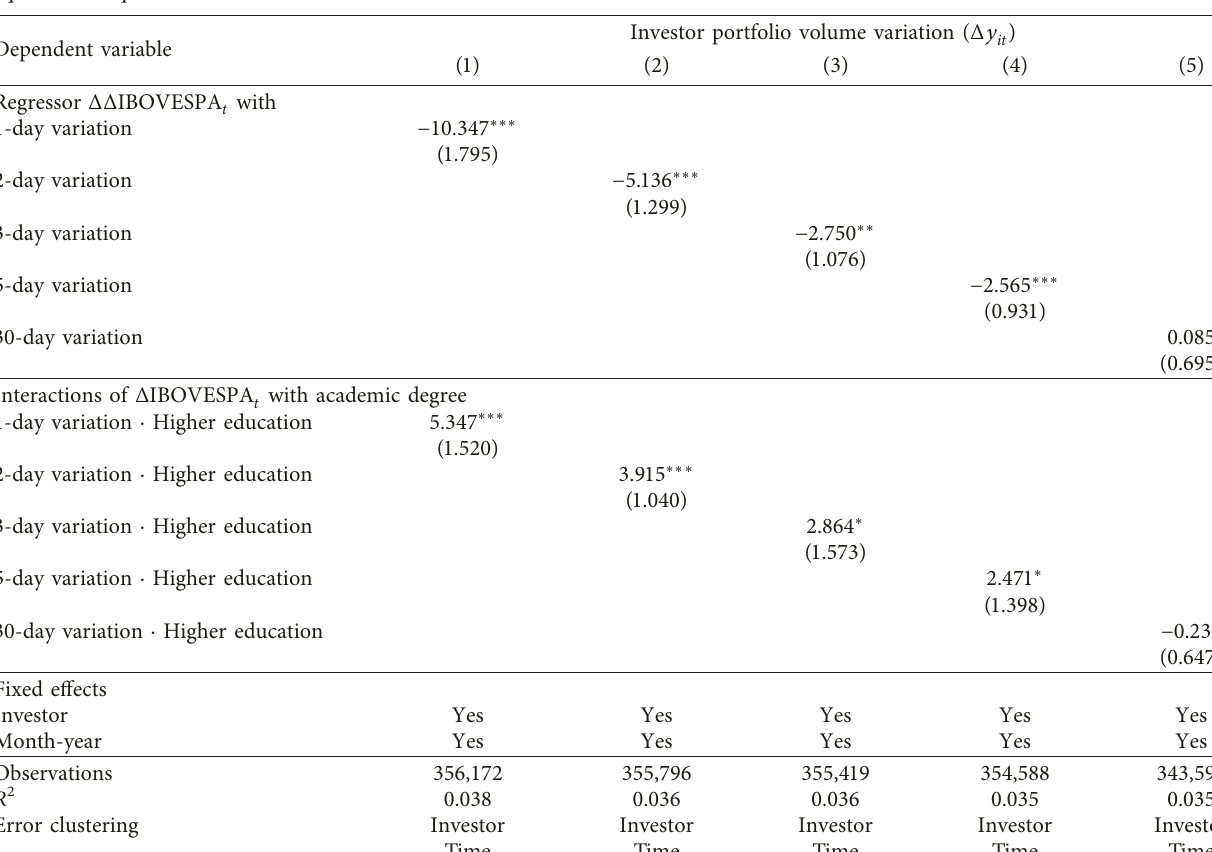
Table 4: This table reports output from Regression (6). We ask whether investors with higher academic degree have different sensitiveness with respect to their investment portfolio to IBOVESPA index changes. We only use changes rather than past averages because the former has greater prediction power as reported by our feature selection procedure. The dependent variable is the variation of portfolio investment volume of investor i at time t in the Brazilian stock market from the beginning of 2016 to the end of 2018. Regressors are 1- (1), 2- (2), 3- (3), 5- (4), and 30-day (5) IBOVESPA index variations, as well as their interaction with the investor’s academic degree. The panel is on a daily frequency basis. Following Petersen [50]; we double-cluster standard errors at the investor and time levels. Significance levels: ∗ p < 0 . 10, ∗∗ p < 0 . 05, ∗∗∗ p < 0 .